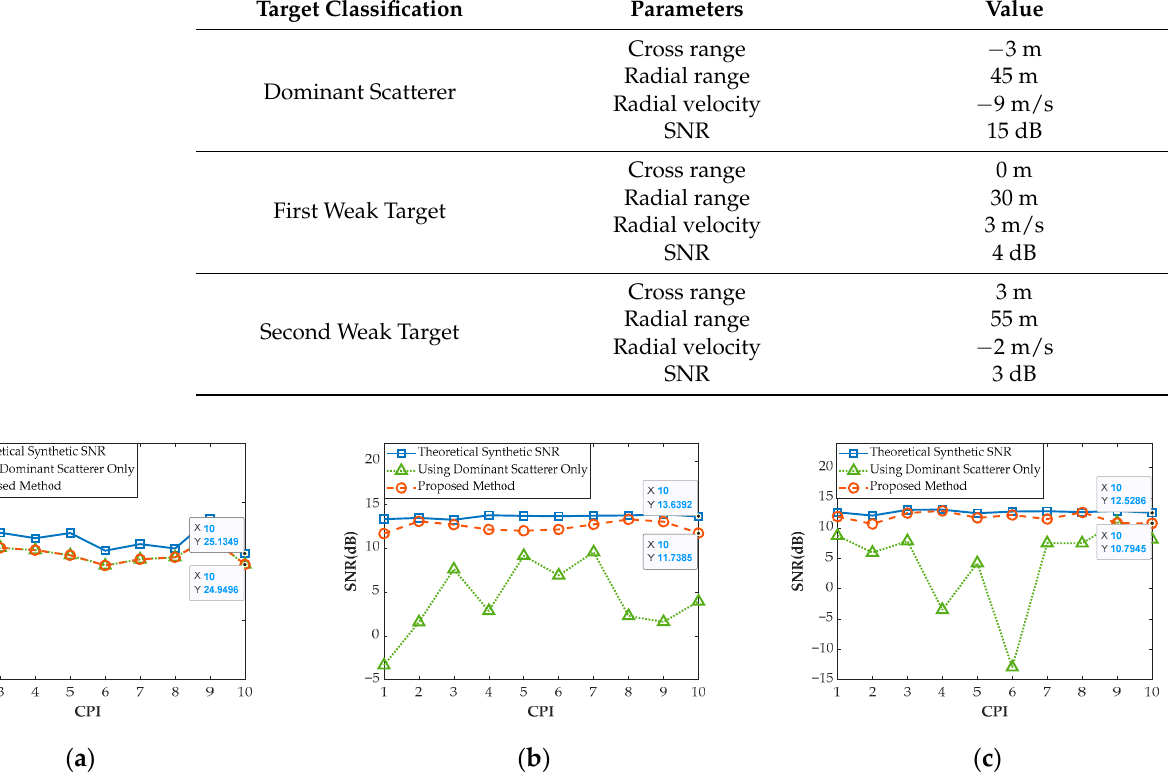
Figure 12. Multi-target coherent-on-receive synthesis results in consecutive CPIs. ( a ) Results of the dominant scatterer. ( b ) Results of the first weak target. ( c ) Results of the second weak target.